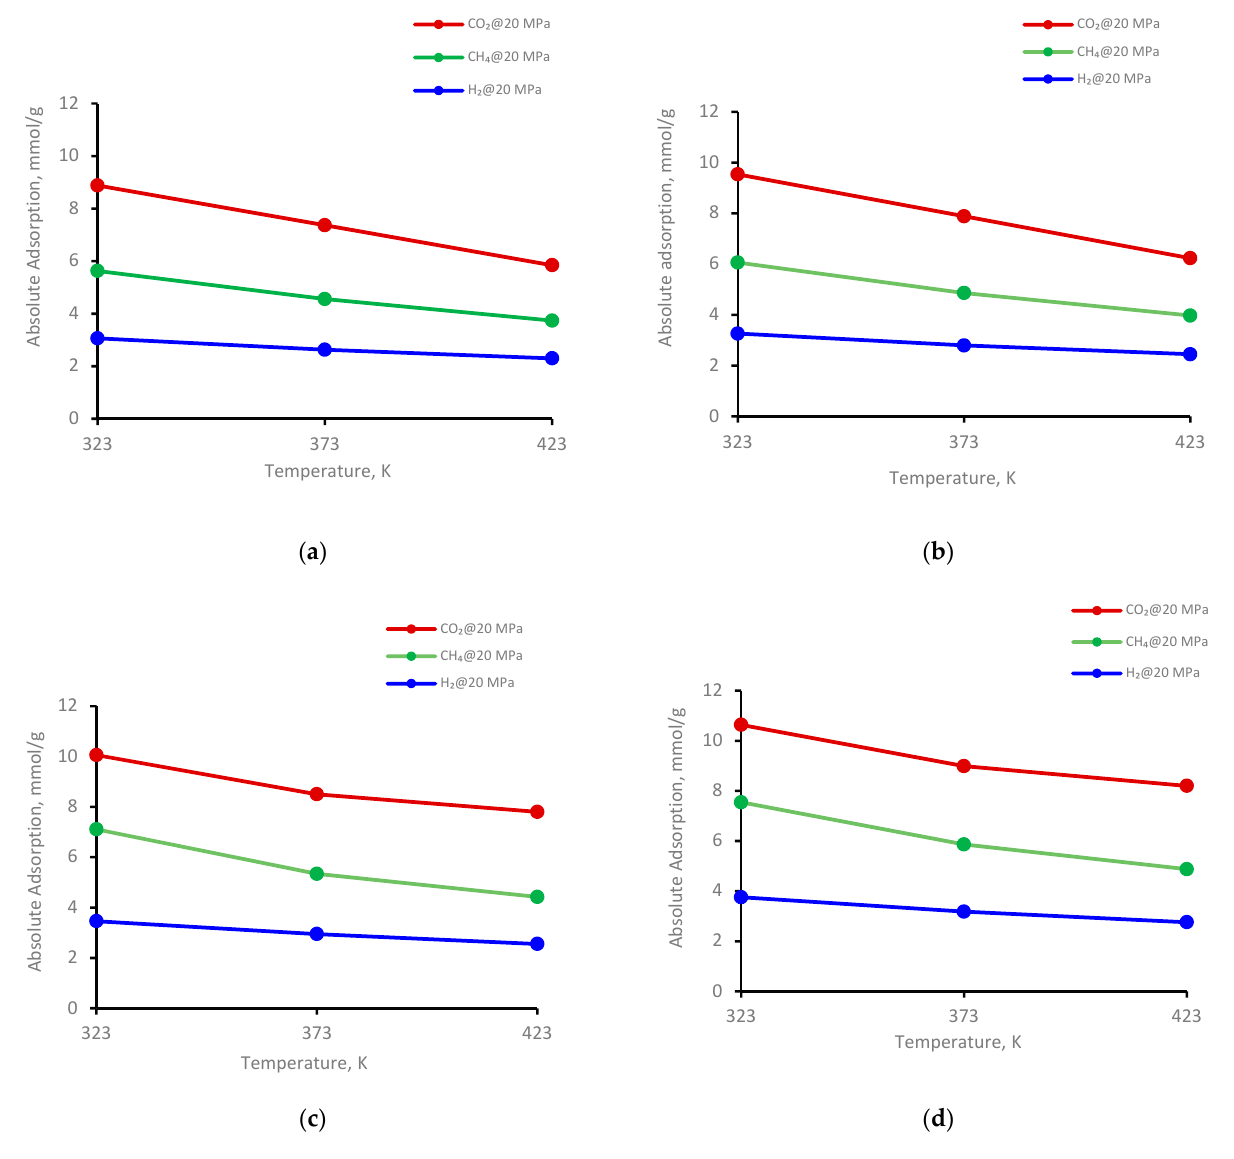
Figure 3. Gases adsorption trend versus temperature at 20 MPa on kerogen; ( a ) II-A, ( b ) II-B, ( c ) II-C, ( d ) II-D.